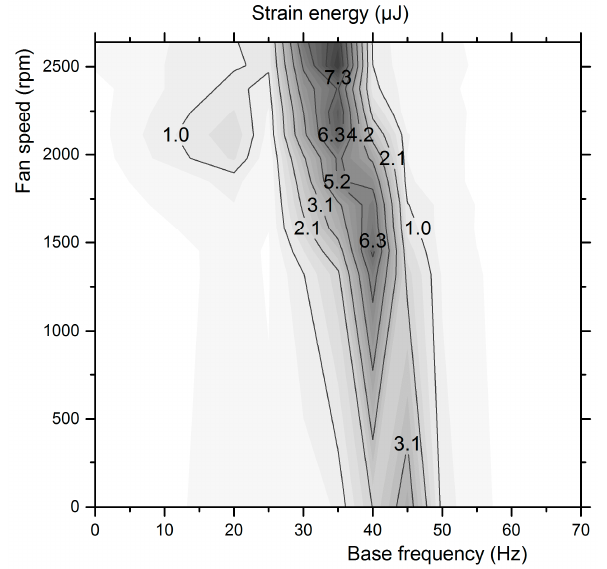
Figure 16. Transducer maximum strain energy map in combined base and aerodynamic excitation frequencies.